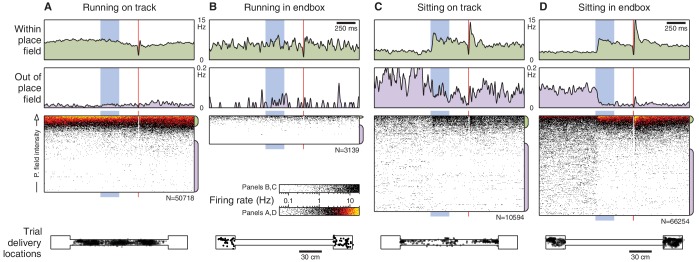
State-dependent responses, separated by location.In Figure 3, most running trials occur on the track, whereas the sitting trials occur mostly in the endboxes. To check whether it is behavior (run vs. sit) or location (track vs. endbox) that is the relevant feature, we repeated this analysis for each of the four conditions. Panels (B) and (C) contain fewer trials than (A) or (D), so their spike rasters are shown at a different scale.